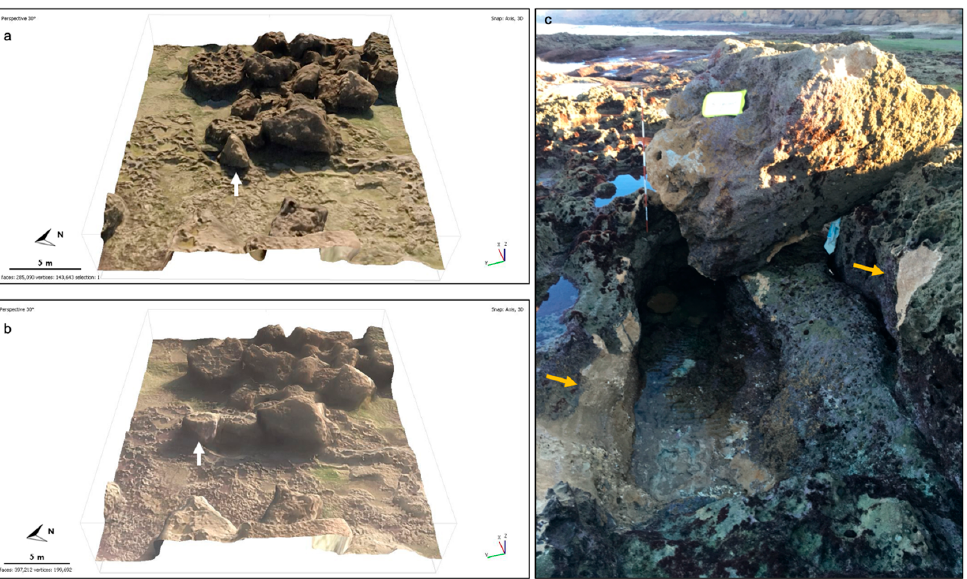
Figure 13. ( a ) Initial position of boulder B30 in September 2019 (white arrow) and ( b ) in December 2019; ( c ) field photo of B30 overturned; orange arrows show striae on the rock platform and adjacent boulder caused by B30’s movement.